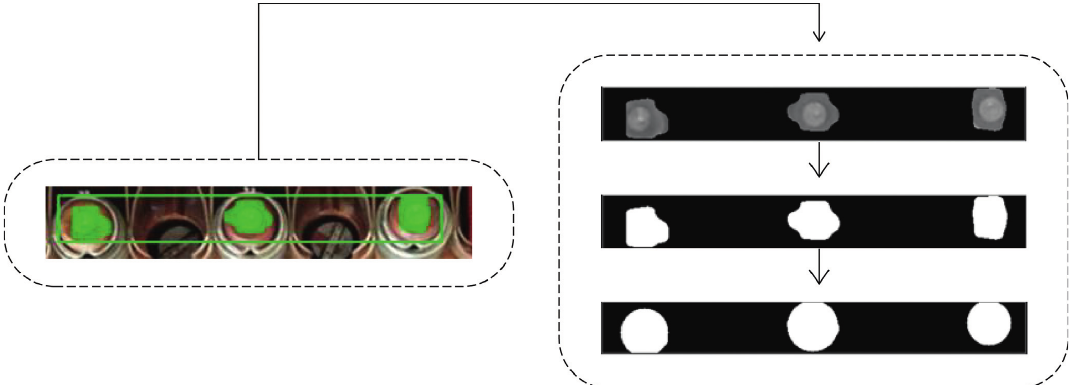
Figure 10: The treatment process of moving contact.